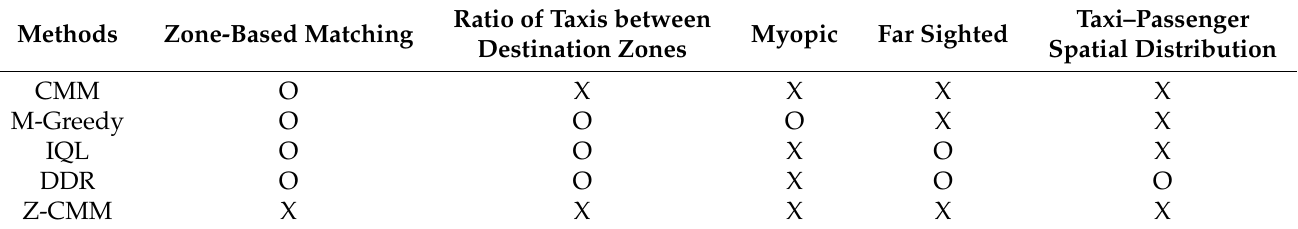
Table 2. Five methods for taxi dispatch decision